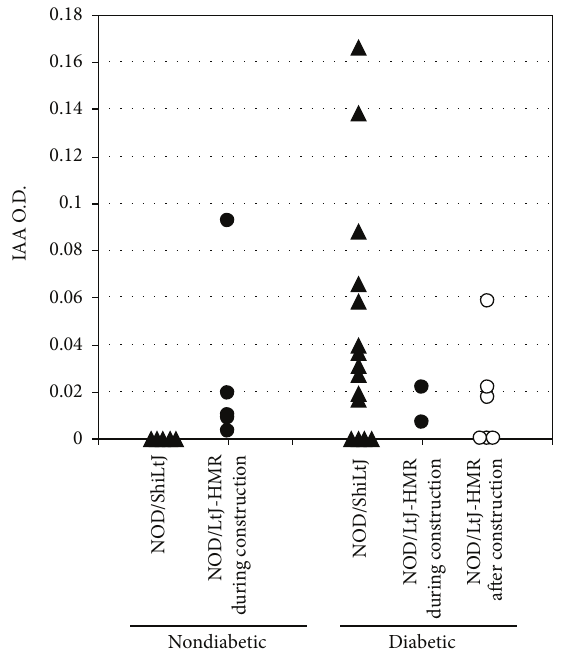
Figure 5: Serum IAA levels as an indication of an ongoing autoimmune response towards pancreatic islets. The serum IAA levels are shown for every mouse group and segregated according to the health status (i.e., diabetic versus nondiabetic). Note that there are no nondiabetic mice from the NOD/LtJ-HMR mice born after construction. Each dot represents one